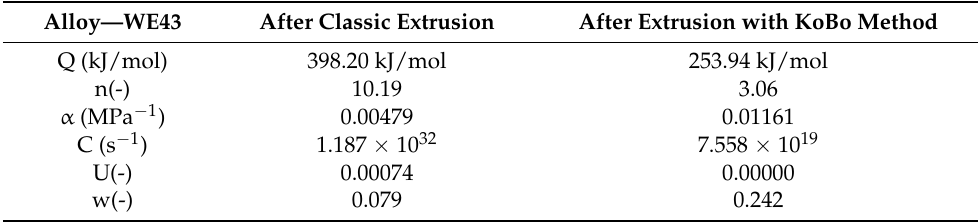
Table 4. Calculated constants in Equations (2) and (6) for the investigated WE43 alloy.